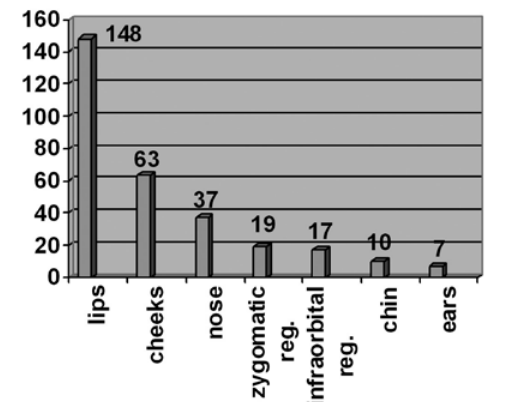
Figure 2. Localization of dog bite injuries in different facial